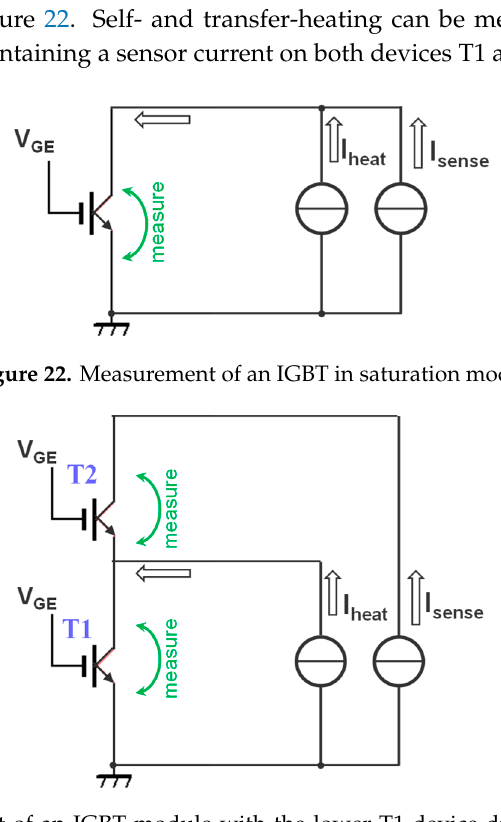
Figure 23. Measurement of an IGBT module with the lower T1 device driven and with self- and transfer-heating measurement.